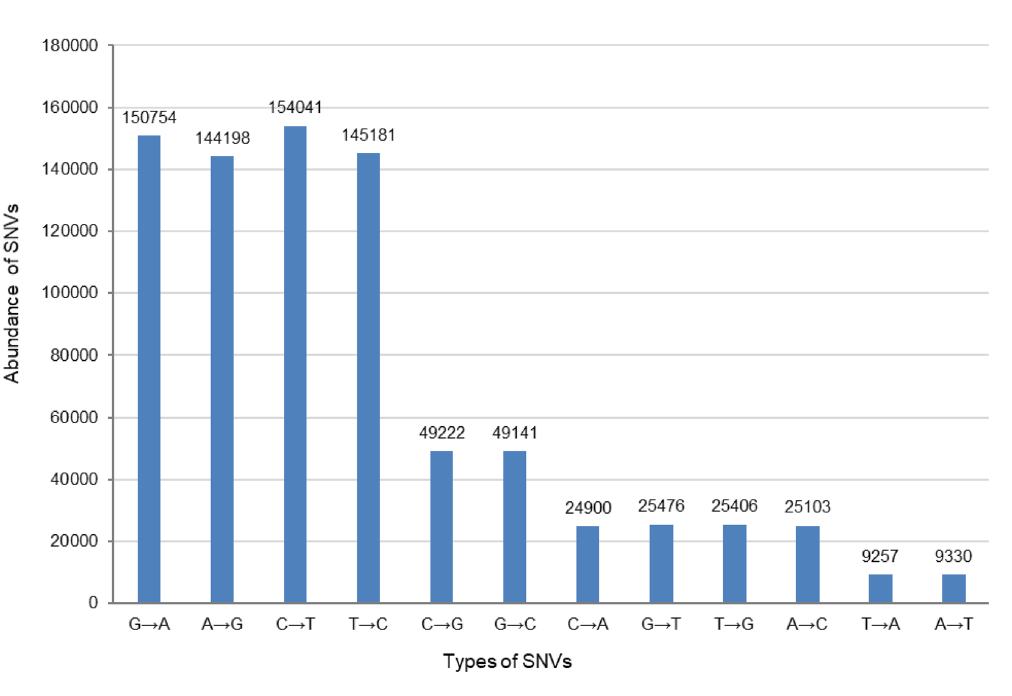
Figure 3. Frequency of all detected SNV types in LUMs and reference genomes with > 1% relative abundance in the